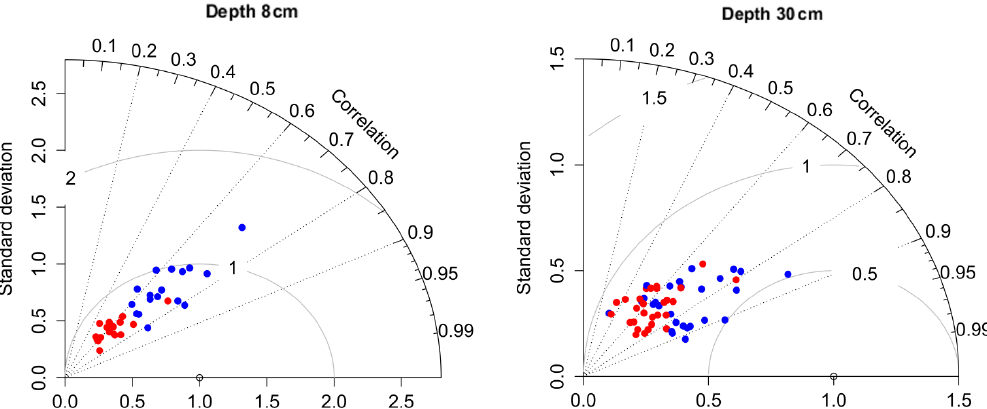
Figure 6. Taylor diagrams (TDs) drawn from the comparison between in situ observed and SFX-simulated soil moisture for two different soil depths and the two different models. Blue dots indicate SFX statistics, and red dots indicate CLM